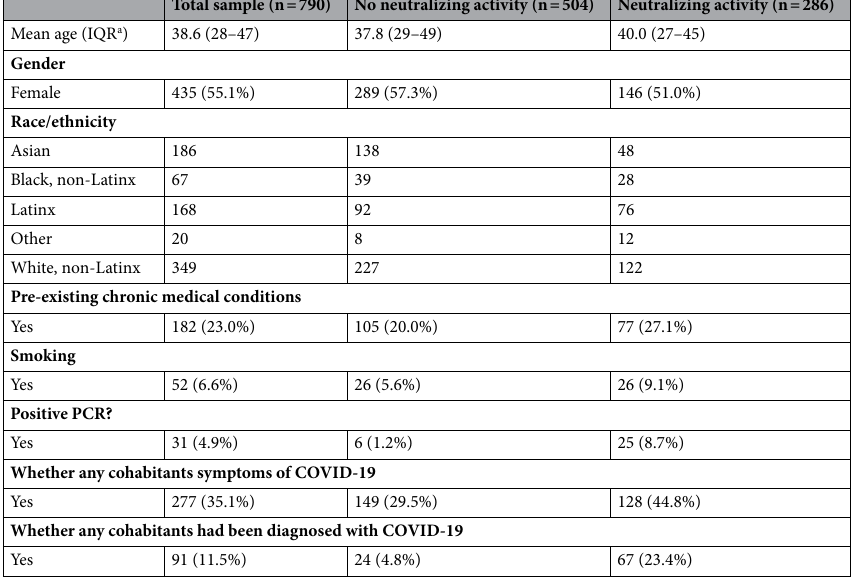
regression model adjusted for the same covariates demonstrated a positive linear association between surrogate neutralization levels and COVID-19 symptom severity score (β = 0.34; R 2 = 0.16; p < 0.001) (Table 3, Model C). Neutralization activity and household contacts. Individuals with neutralization activity were more likely to report a household member who had been diagnosed with COVID-19 than participants without detect- able levels of NAb activity (23.4% vs. 4.8%; χ 2 = 17.83; df = 1; p < 0.001). Similarly, participants with neutraliza- tion activity were also more likely to have a household member who reported one of the 11 symptoms potentially indicative of COVID-19 (44.8% vs. 29.5%; χ 2 = 18.68; df = 1; p < 0.001). A regression model adjusted for age, birth sex, race, and preexisting chronic medical conditions demonstrated that living with someone previously diagnosed with COVID-19 or having a household member with symptoms potentially indicative of COVID-19 was positively associated with levels of surrogate neutralization activity (β = 0.27; R 2 = 0.07; p < 0.0001) (Table 3,